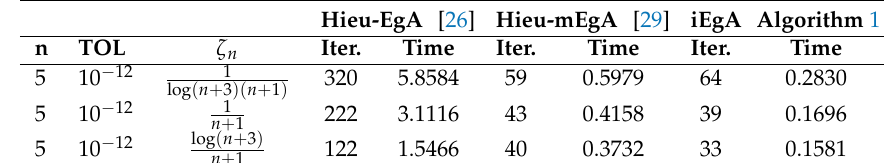
Table 1. Example 1: Numerical values for Figures 1–3.